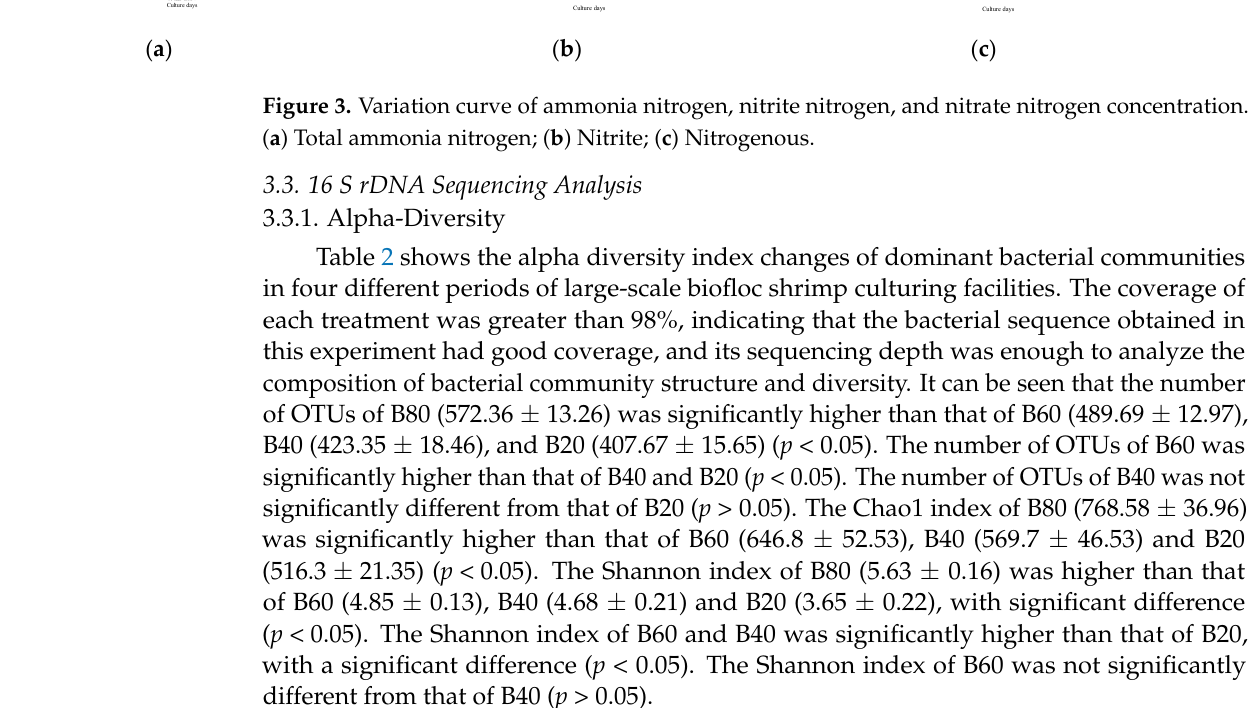
Table 2. Analysis of the alpha diversity index of the bacterial community in four periods.